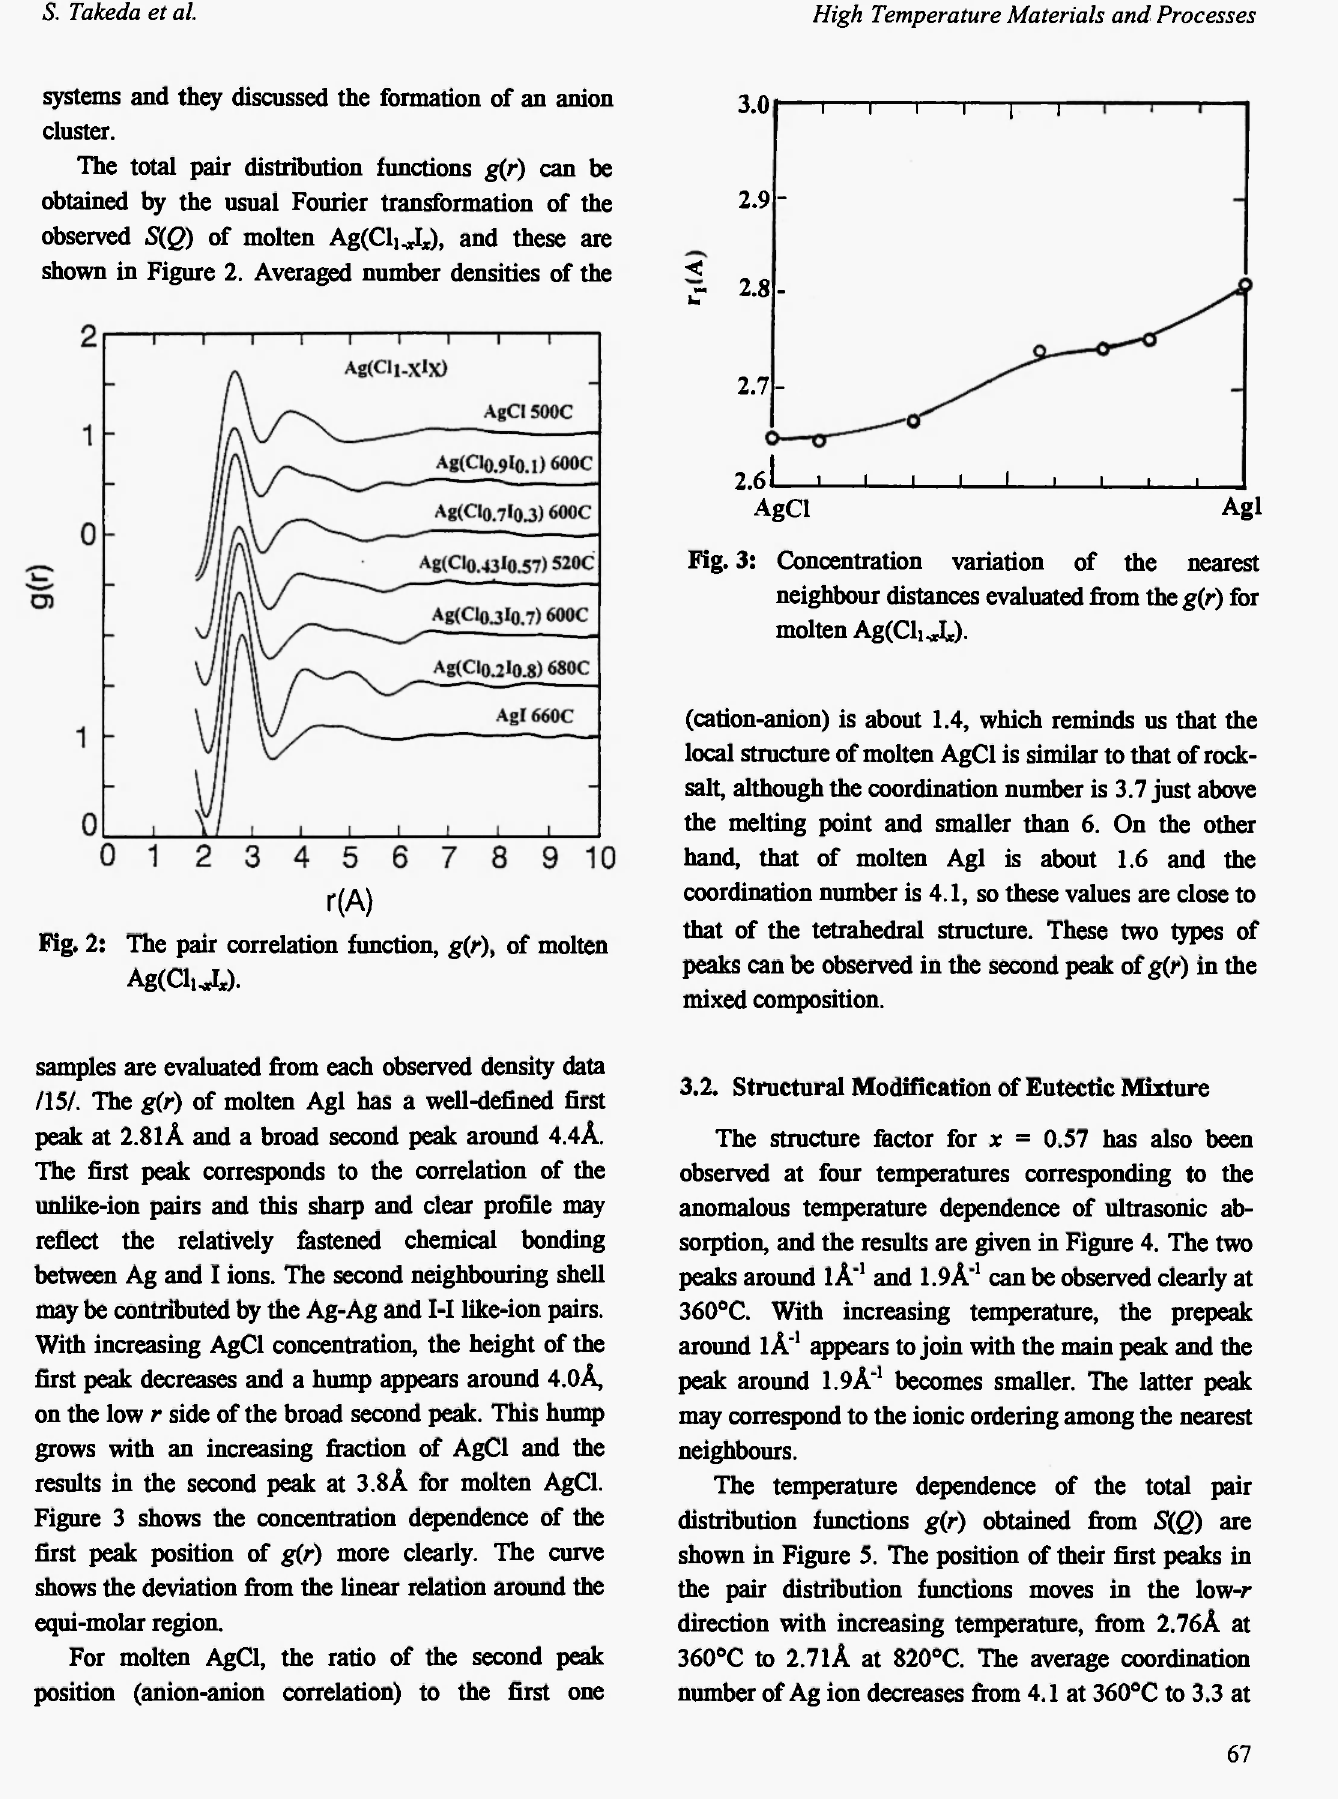
Fig. 3: Concentration variation of the nearest neighbour distances evaluated from the g(r) for molten Ag(Cli